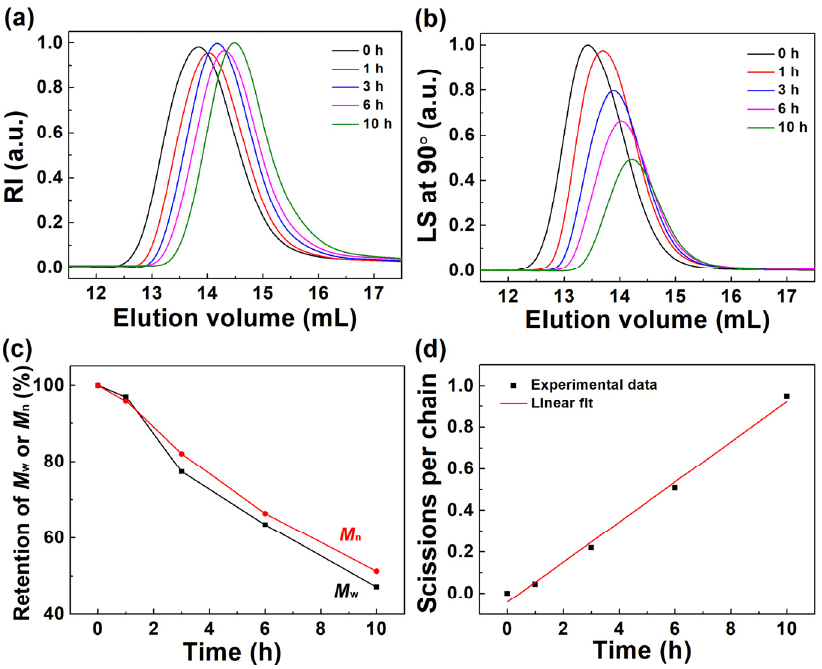
Figure 8. ( a ) RI and ( b ) LS at 90° signals as a function of elution volume. Retention of ( c ) M w and M n and ( d ) scissions per chain of (6FDA-DMB) PAA in the diluted solution stored at 25 °C for different times. Table 6. Molecular parameters of (6FDA-DMB) PAA in the diluted solution stored at 25 °C for different times, measured by GPC-RI-MALLS-VIS.